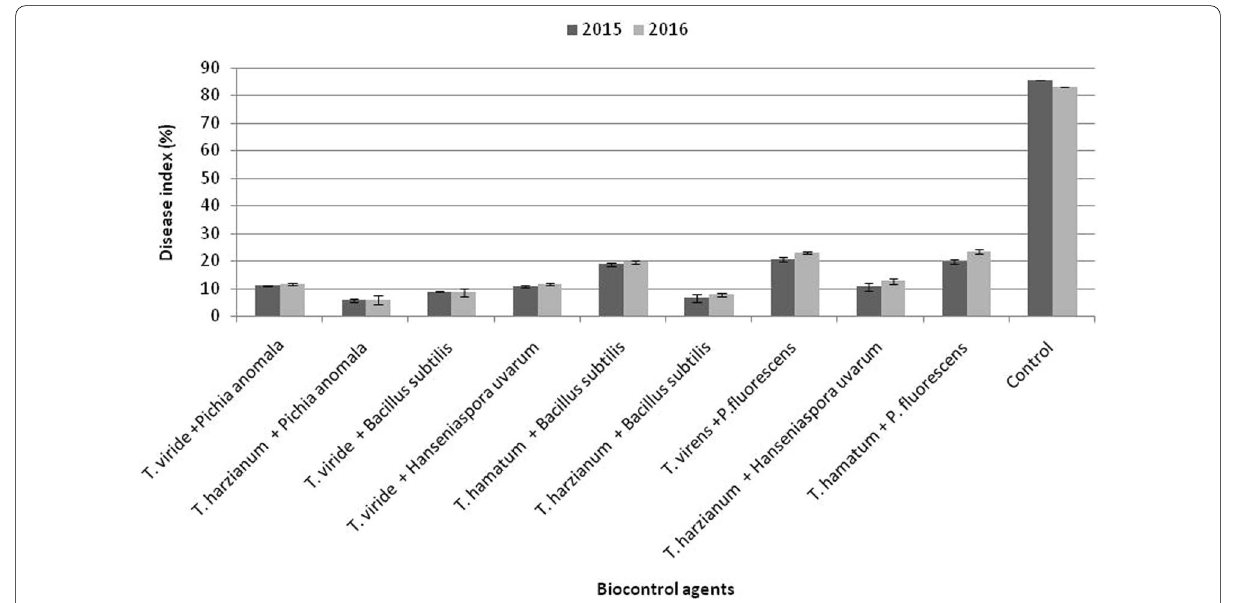
Fig. 4 Integration of effective bio-control agents for the management of anthracnose on mango fruits after artificial